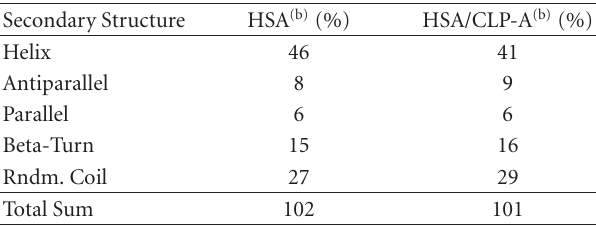
Table 2: Secondary structure evaluation from far-UV